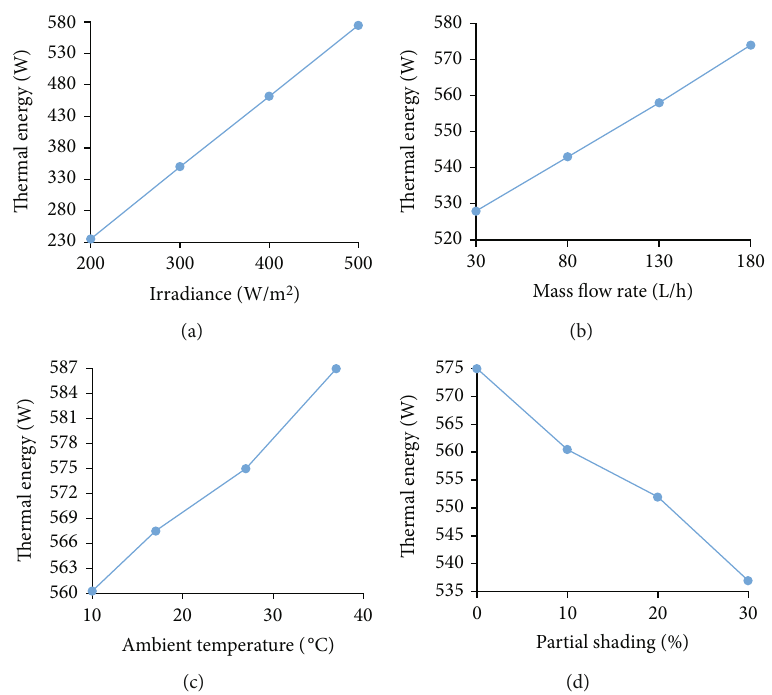
Figure 16: Outcome of (a) G , (b) V